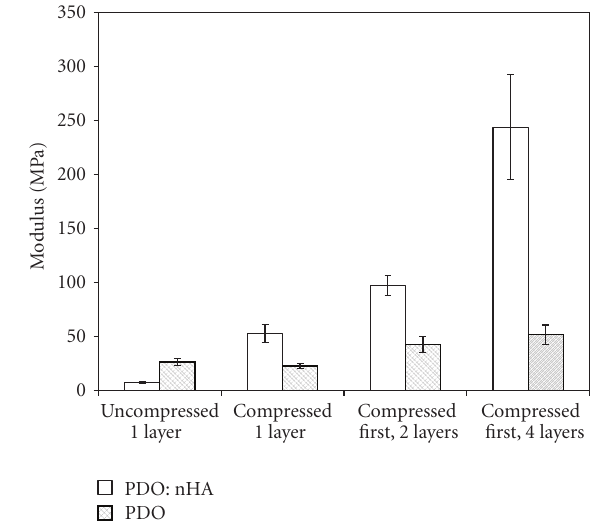
F 7: Effects of compression and multiple layers on the stiffness of electrospun PDO and PDO:nHA